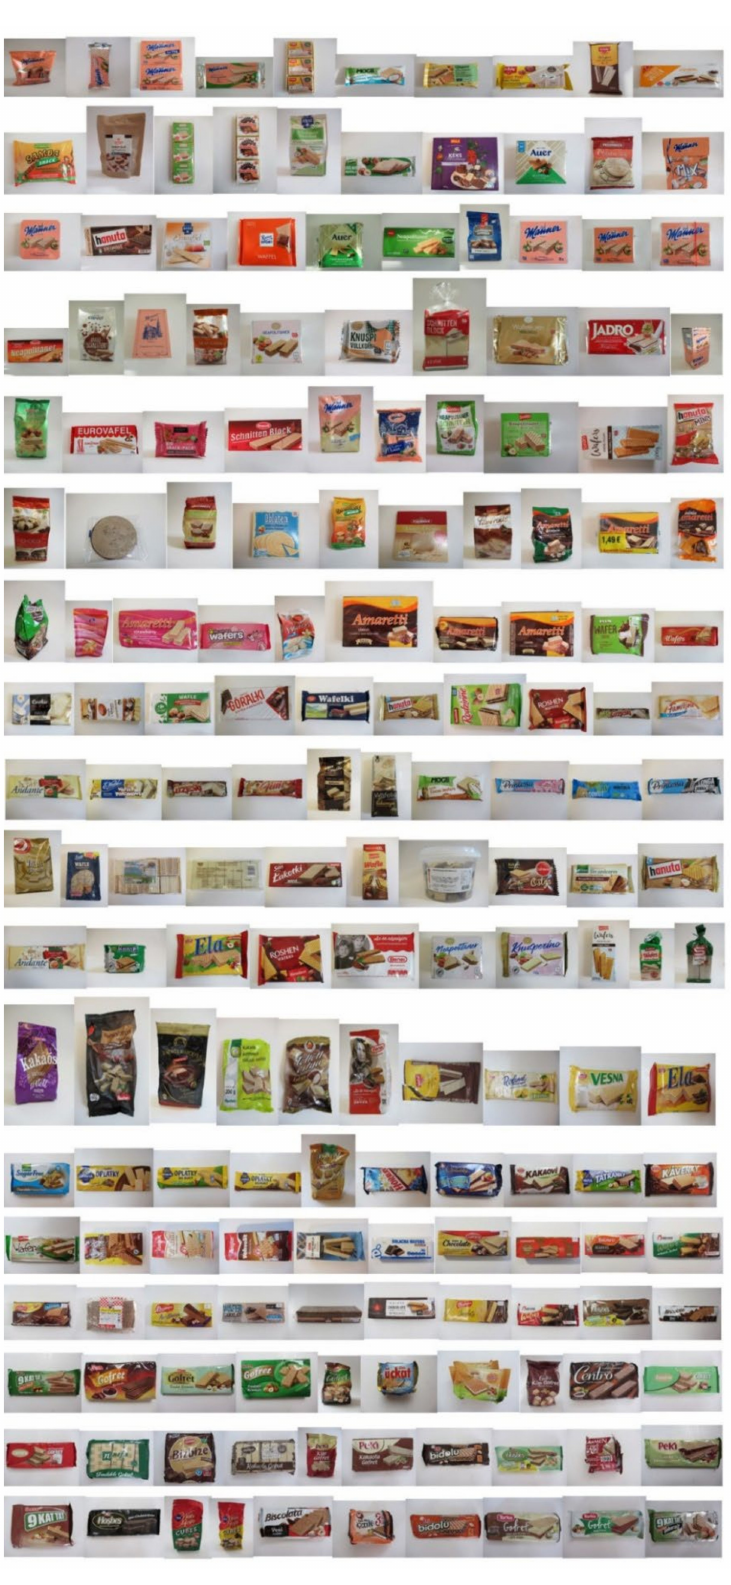
Figure A1. Pictures of all collected